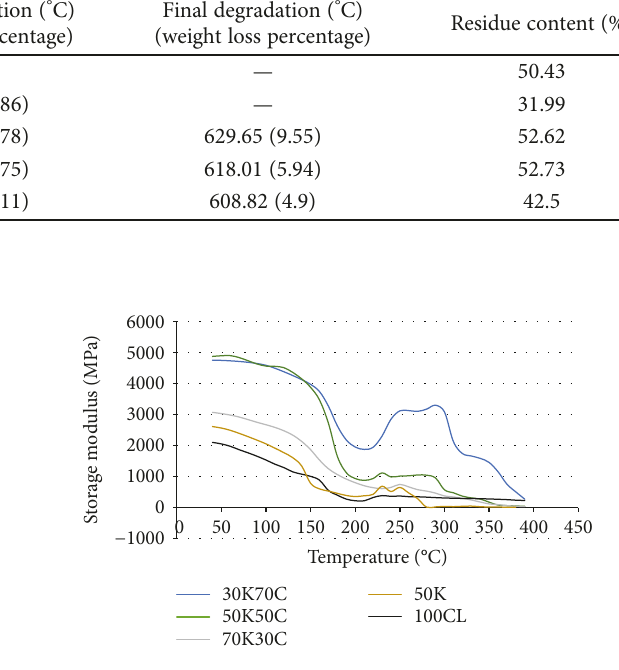
Figure 5: Storage modulus of the hybrid composites (MPa).